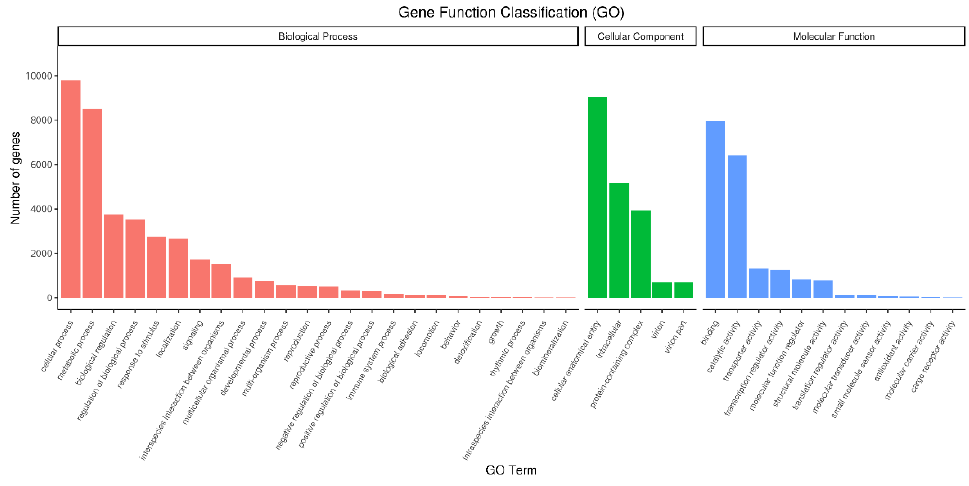
Figure 4. GO Annotation Classification Statistics Chart. The abscissa in the figure is the GO term, and the ordinate is the number of genes annotated to the GO term.